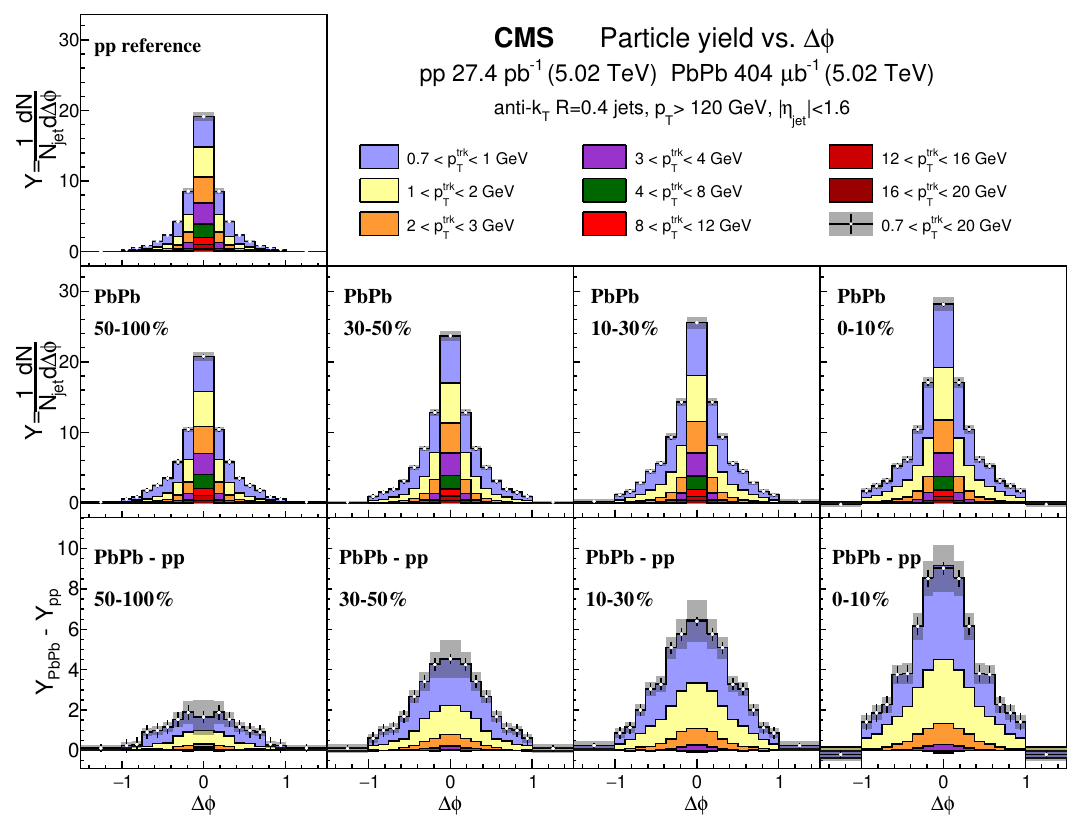
Figure 2 . The distribution of jet-correlated charged-particle tracks with j (cid:1) (cid:17) j < 1 : 0 as a function of (cid:1) (cid:30) in pp (top left) and PbPb (middle row) collisions. The PbPb results are shown for di(cid:11)erent centrality regions. The bottom row shows the di(cid:11)erence between the PbPb and pp data. The intervals in p trk are indicated by the stacked histograms. The inclusive points (0 : 7 < p trk T are shown by open white circles. The grey bands surrounding these points show the total systematic